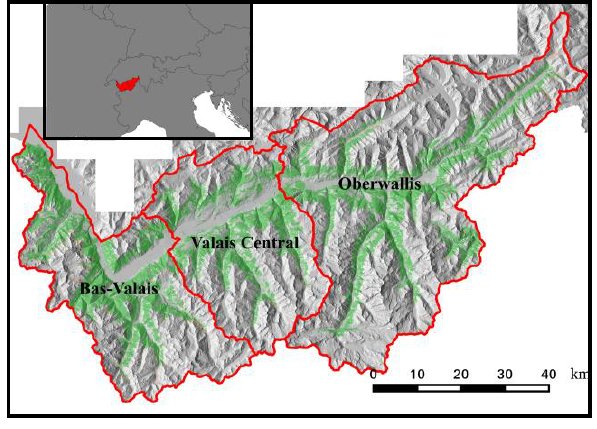
Figure 1. Map of study area and monitor the dynamics of Swiss forests, based on a network of field sample plots. The sampling (Keller 2005) is based on a 1.4 km grid. Trees with a diameter at breast height (DBH) above 12 cm are inventoried up to a distance of 7.98 m from the grid node, and trees with DBH larger than 36 cm up to 12.62 m. From the tree-level measures, the Swiss Federal Institute for Forest, Snow and Landscape Research (WSL) derives plot-level forest parameters. In this study, mean height, maximum height, mean diameter, stem density, stem volume and basal area are considered. Table 1 presents the statistics of the 688 plots located in the study area and measured in 2006 during the NFI III campaign. On 47 plots, no tree was measured. Height parameters are not calculated in 229 plots, due to sampling procedures. Forest parameters are highly variable, with volumes from 0 to 1439 m 3 /ha and basal areas from 1 to 139 m 2 /ha.